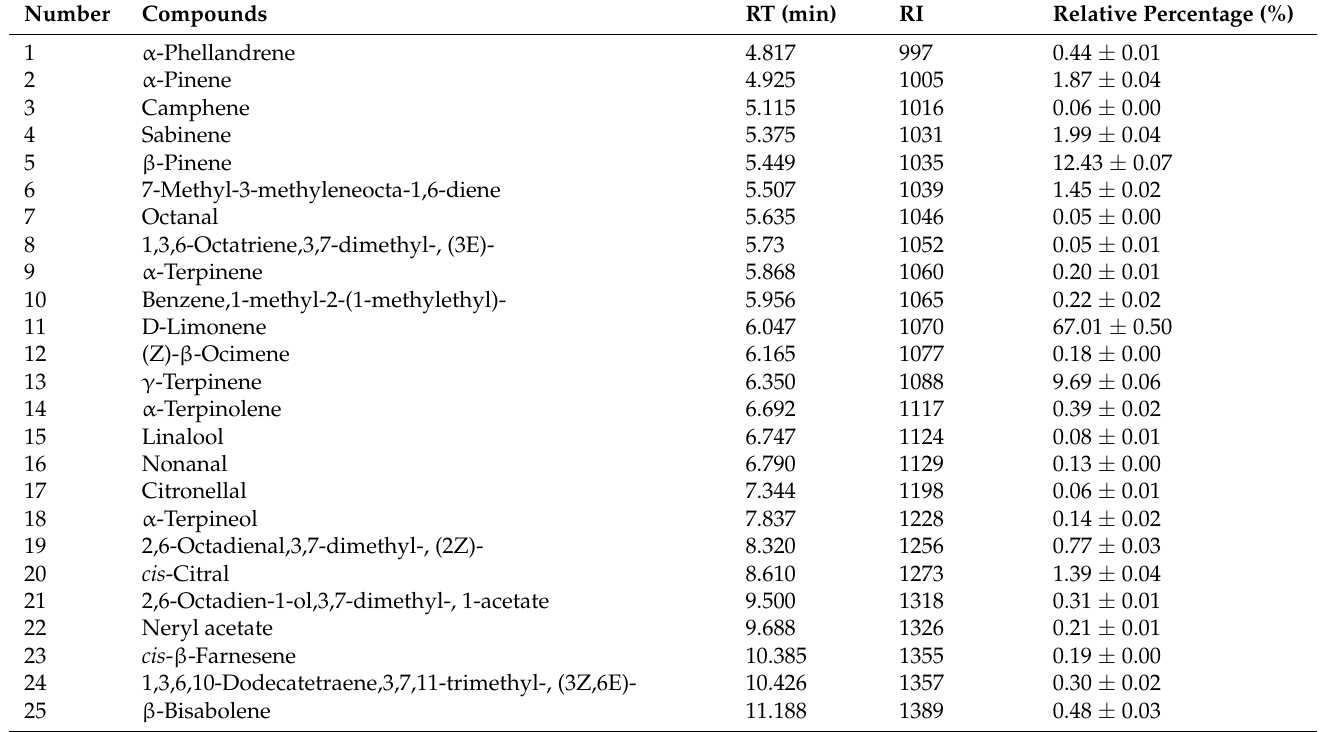
Table 1. Chemical composition and relative percentage of identified compounds in the lemon essential